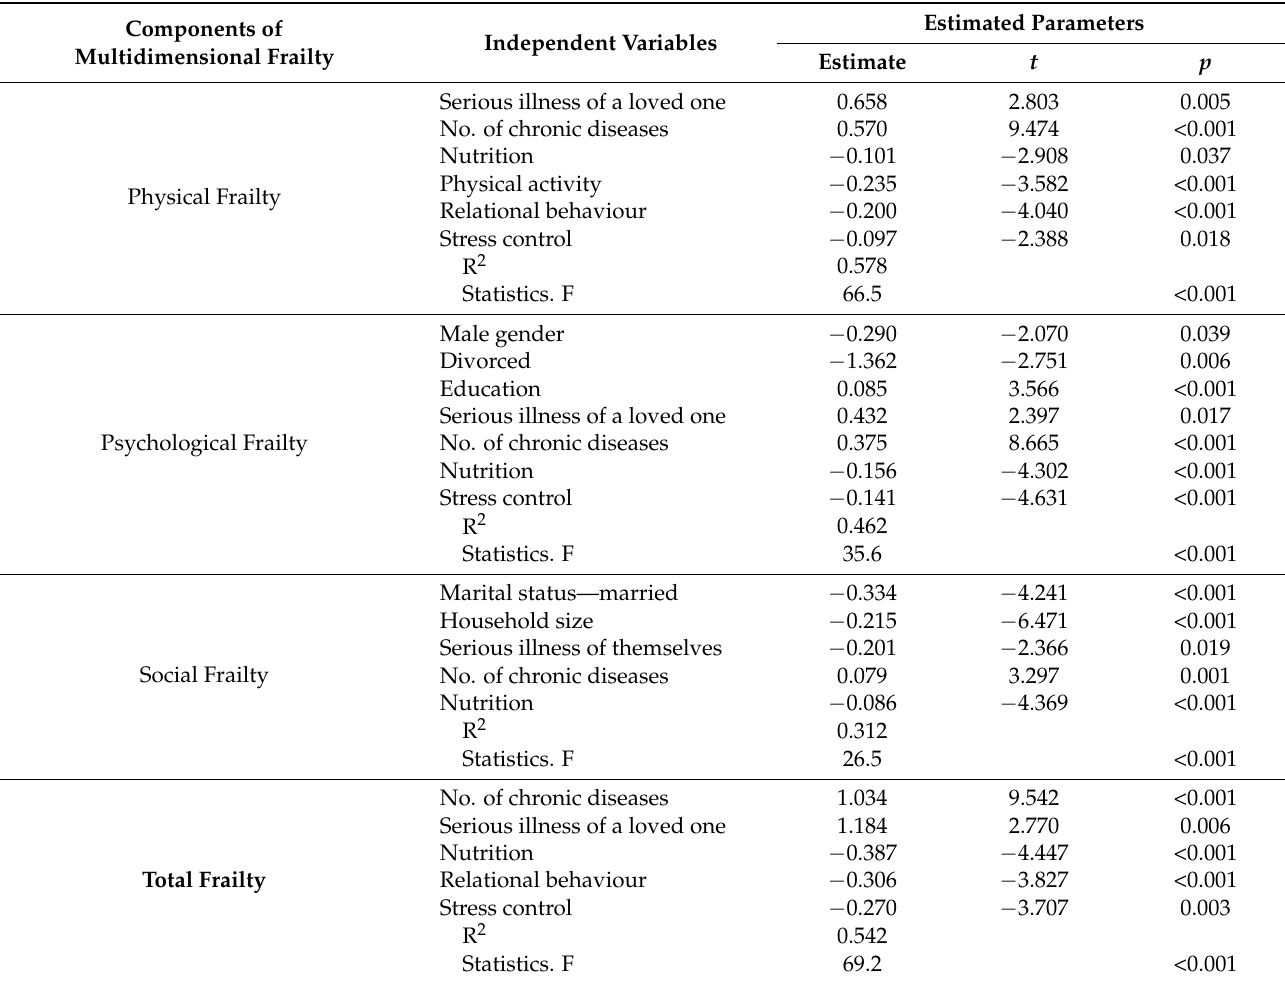
Table 6. Multivariate linear regression model with frailty components from the TFI as dependent